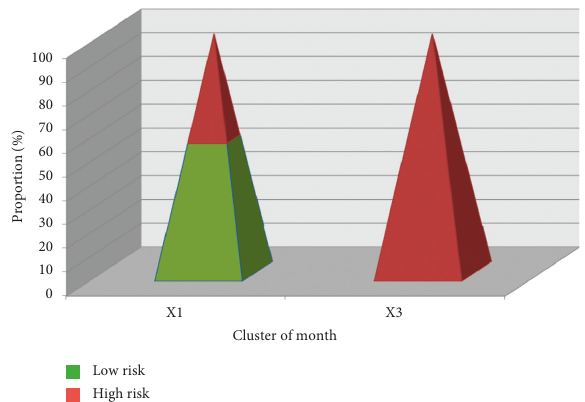
Figure 8: The difference in overturning between different clusters.